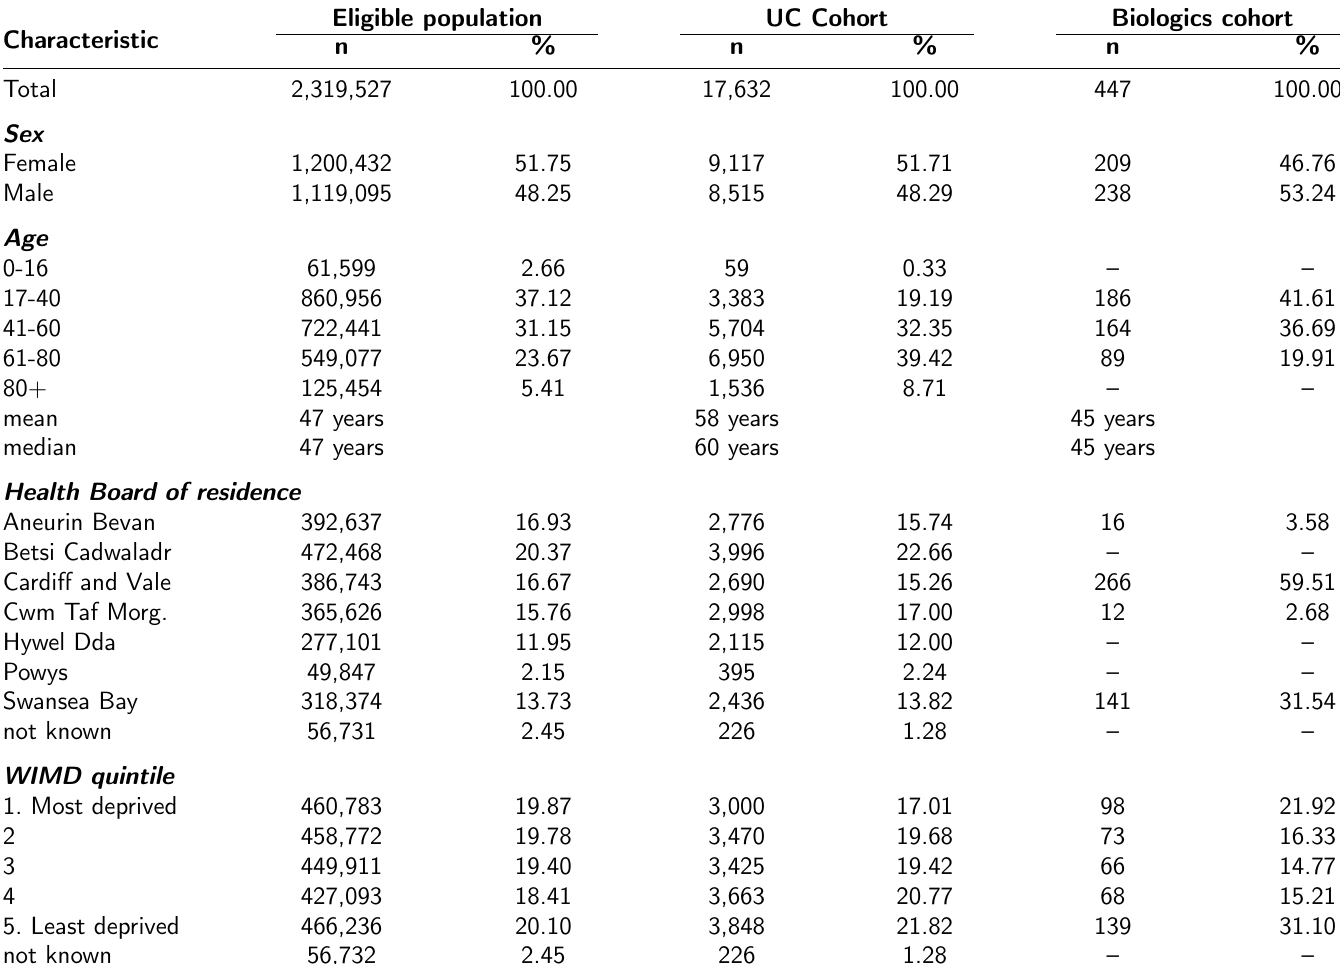
Table 1: Population and cohort composition, stratified by: Age, Sex at birth, Health Board of Residence, and Deprivation Quintiles. 28 patients treated at one Health Board in our study resided in a different Health Board Characteristic